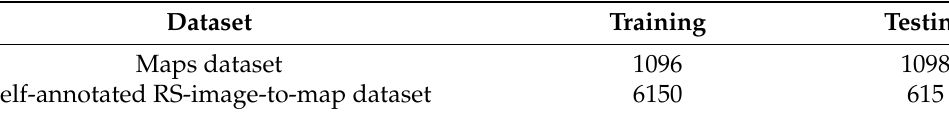
Table 1. Detailed information for the training and testing.